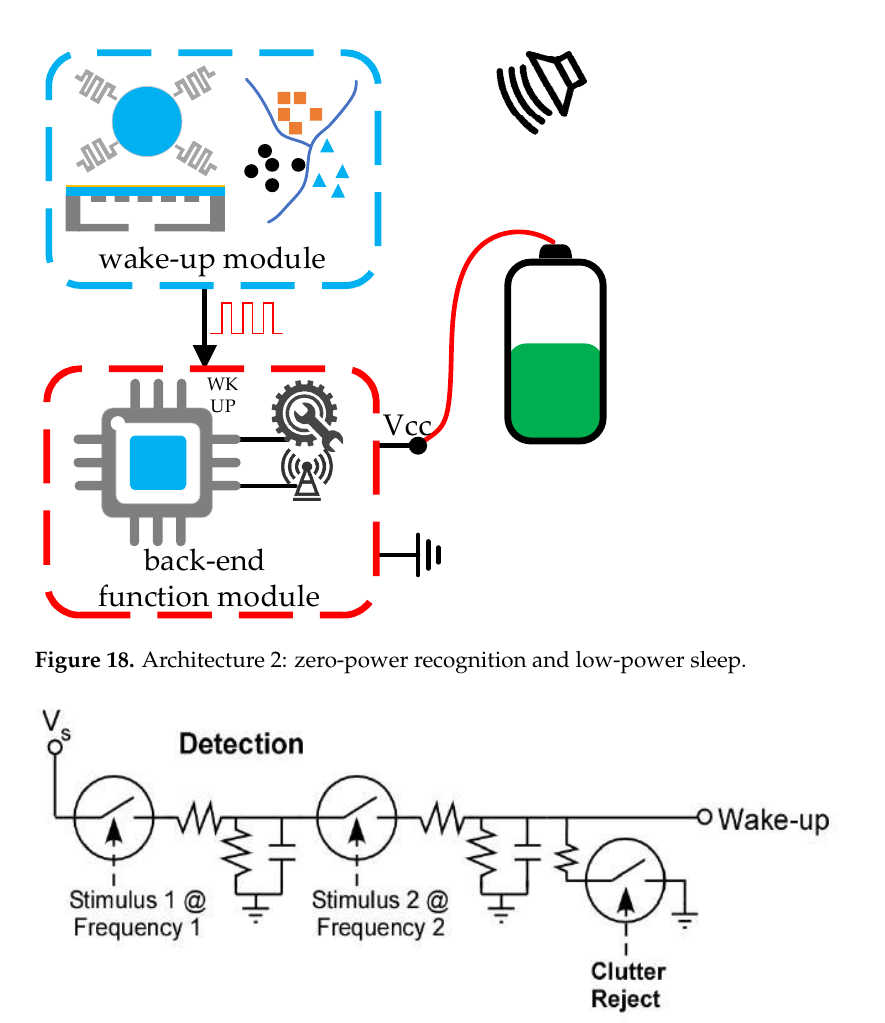
Figure 20. Architecture 3: low-power recognition and zero-power sleep. A wake-up chip containing a switch is able to turn off the backend function module completely instead of keeping it in a low-power sleep mode, as shown in Figure 21 [70]. It should be noted that the wake-up chip in Figure 21 is different from the definition in this paper. Instead, the entire module in Figure 21 is regarded as the wake-up chip since it only achieves functions of acoustic sensing, recognizing, and wake-up. The power con- sumption of the chip is 420 μW, and the size is of centimeter-level. Optimizations of the chip are required for its further application in acoustic wake-up microsystems.